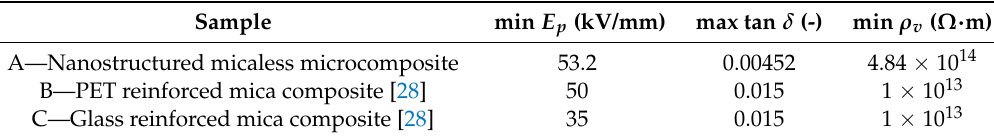
Figure 12. Normal probability plots of investigated parameters of nanostructured micaless microcomposite. Table 2. Minimum/maximum values of key dielectric parameters of investigated